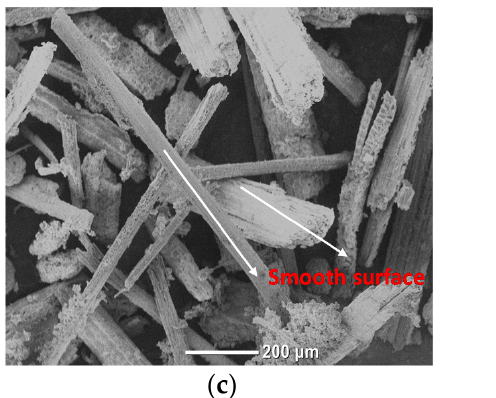
Figure 3. SEM of ( a , b ) PLA-UTDPWF, and ( c , d ) PLA-NaOH.